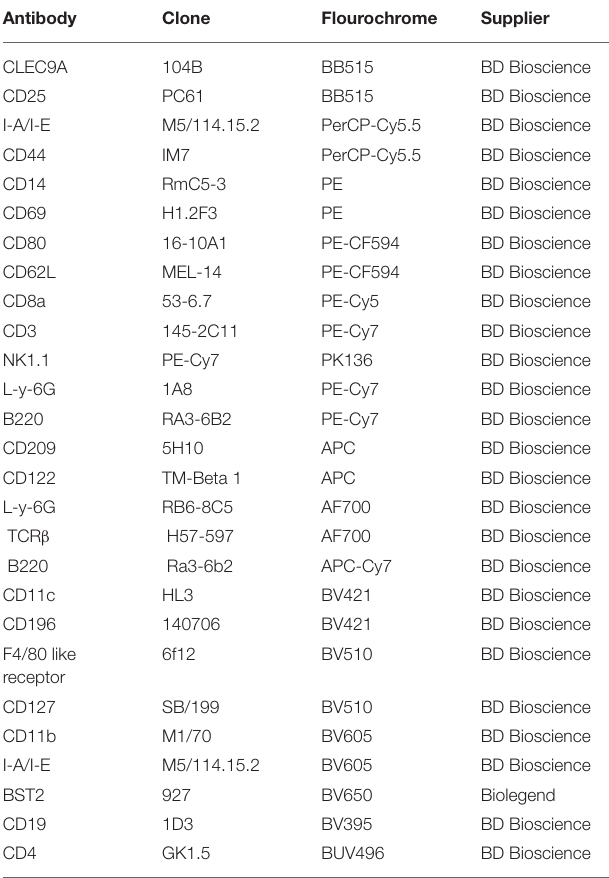
TABLE 1 | Antibodies used to label dendritic cells and T cells.